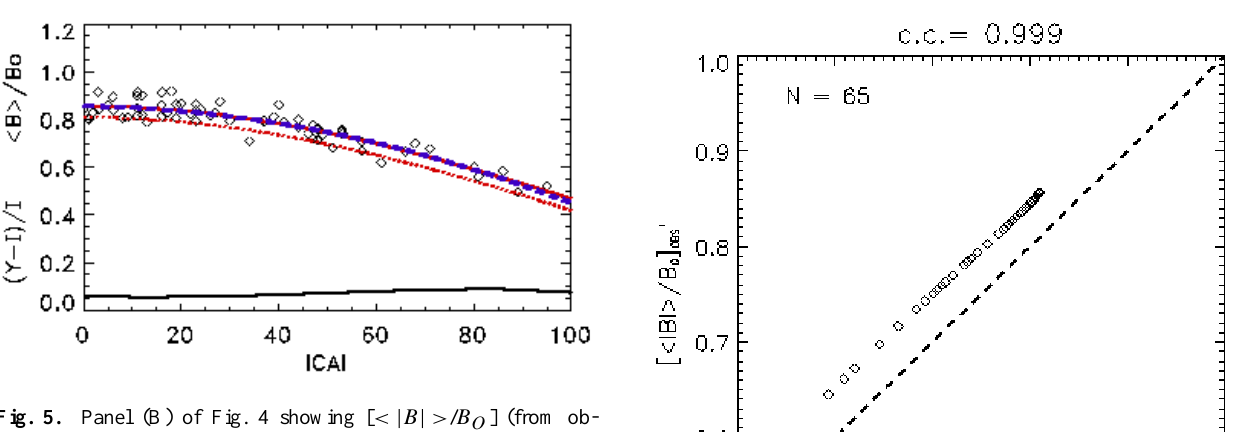
Fig. 5. Panel (B) of Fig. 4 showing [ < | B | > / B O ] (from ob- servations) vs. | CA | (in %), given by the black diamonds. The quadratic curve fitted version of this ( ≡ Y ) is given by the dashed blue line (the primed quantity of Eq. 17). To this we superim- pose the [ < | B | > / B O ]theory-curve (dotted red ≡ I ), from Eq. (15); see text. The solid red curve is given by Eq. (20); this is the [ < | B | > / B O ]theory,mod estimate. The solid black curve at the bot- tom is given by ( Y − I )/ I ; it is a relative change in [ < | B | > / B O ] between observations and theory (before modification) – see Sect. 4. Fig. 6. [ < | B | > / B O ]obs 0 (from the dashed blue curve of Fig. 5) vs. [ < | B | > / B O ] theory (from the dotted red curve of Fig. 5). These two sets are very well correlated, with c.c.=0.999. (This good cor- relation enables us to calculate S and a in Eqs. 18 and 19). The diagonal dashed line has a slope of exactly 1.0 and shows, by com- Figure 5. Panel B of Figure 4 showing [
/B O ] (from observations) vs. |CA| (in%), given by the black parison, how closely the data follows this diamonds. The quadratic curve fitted version of this ( / Y) is given by the dashed blue line (the primed quantity of Eq.(17)). To this we superimpose the [
/B O ]theory-curve (dotted red / I), Figure 6. [
/B ]obs Ν (from the dashed blue curve of Figure 5) vs. [
/B O from Eq.(15); see text. The solid red curve is given by Eq.(20); this is the [
/B O ]theory,mod (from the dotted red curve of Figure 5). These two sets are very well correlated, estimate. The solid black curve at the bottom is given by (Y-I)/I; it is a relative change in with c.c. = 0.999. (This good correlation enables us to calculate S and a in [
/B O ] between observations and theory (before modification) - see Section 4. Eqs.(18) and (19)). The diagonal dashed line has a slope of exactly 1.0 and shows, by comparison, how closely the data follows this slope.